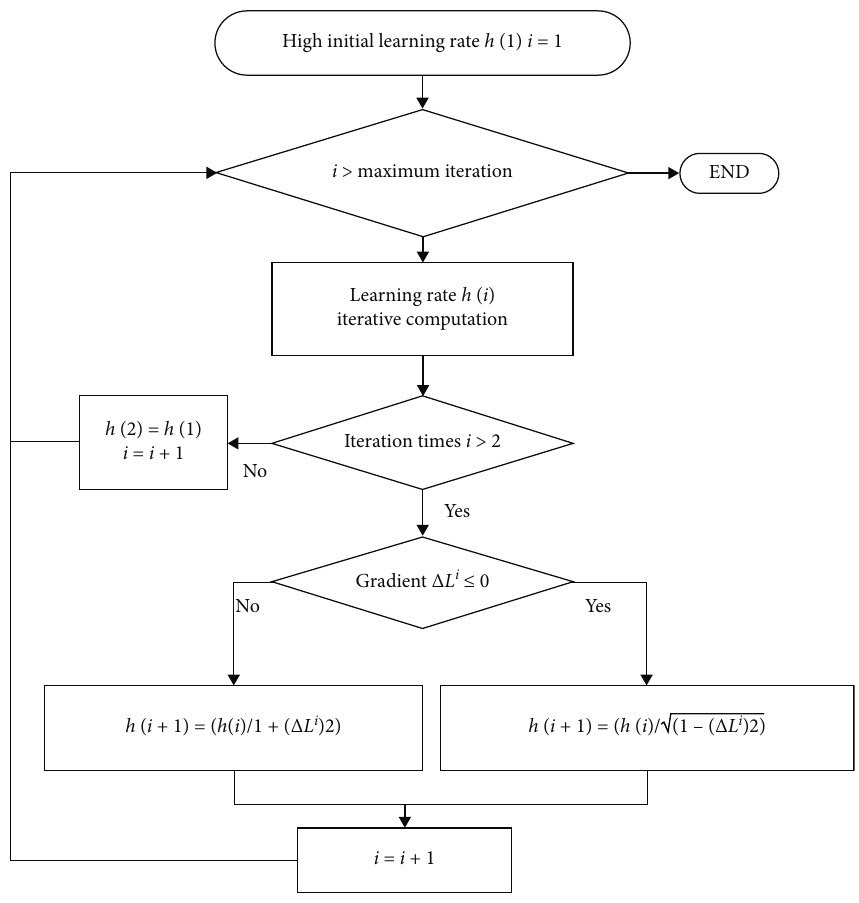
Figure 3: Training flow chart of dynamic learning